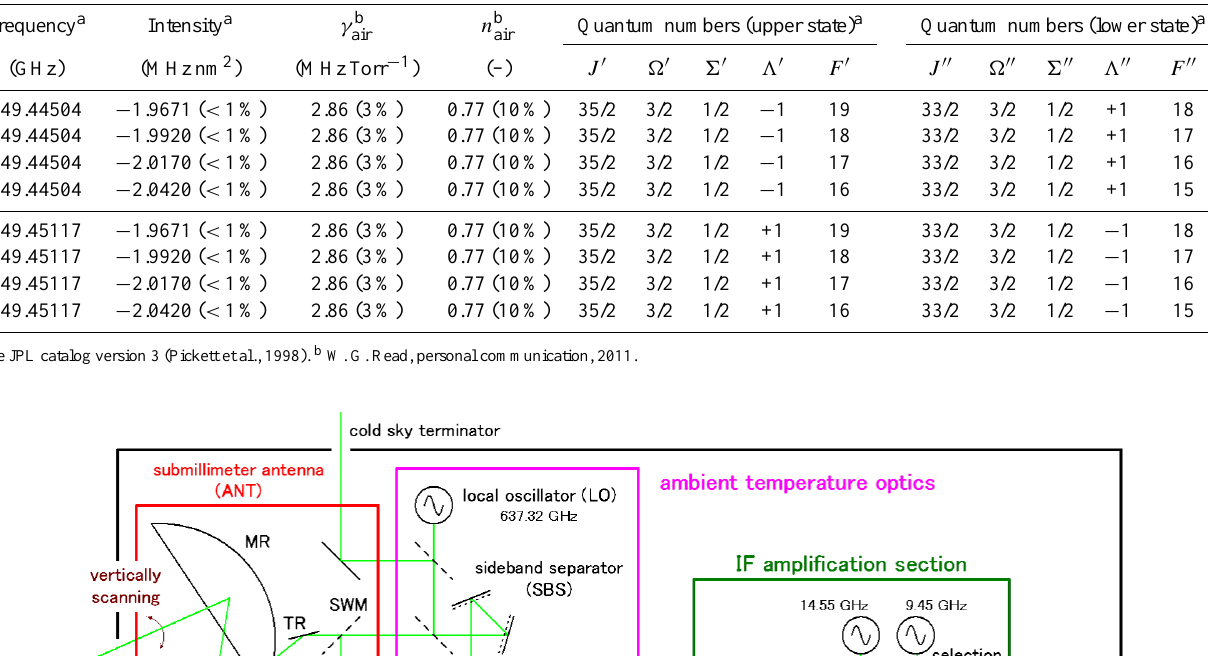
Table 1. Spectroscopic parameters of the ClO lines observed by SMILES. The numbers in parentheses represent uncertainties. Intensity is represented by a base-10 logarithm. The quantum numbers are represented by J , (cid:127) , 6 , 3 and F for the total angular momentum, projection of J on the molecular axis (z-axis), projection of the total electron spin momentum on the z-axis, projection of the total orbit momentum on the z-axis and the real total angular momentum including the nuclear spin momentum I =3/2 ( (cid:127) = 6 + 3 , F = J + I ).